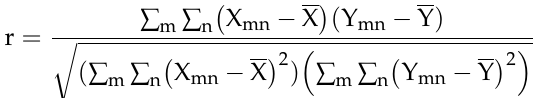
Table 6. Comparison of average peak signal to noise ratio (PSNR) (dB) and pixel cross-correlation of SE at QP = 36 with EXPer for the videos encoded with CABAC.